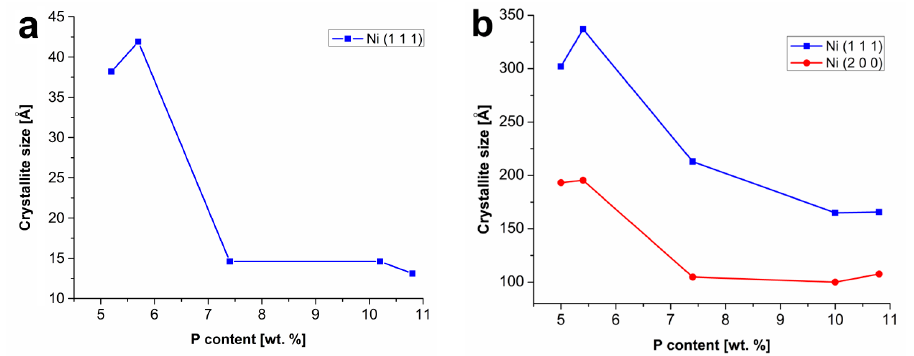
Figure 5. The effect of Ni crystallite size on the P content in ( a ) as-deposited Ni–P coatings and ( b ) heat-treated Ni–P coatings.